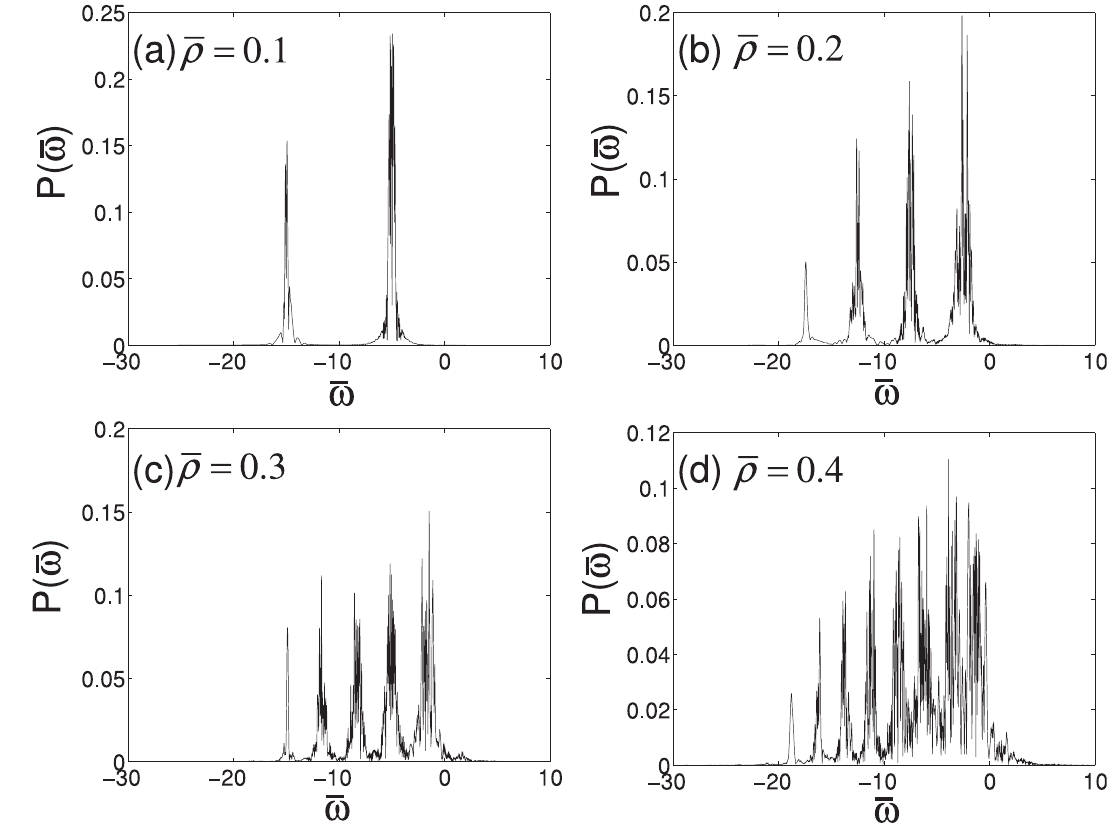
FIG. 4. The transition from quantum SASE to classical SASE: Scaled power spectra, P (cid:5) (cid:1) ! (cid:7) , as a function of scaled frequency (cid:1) ! (cid:1) ! 0 (cid:6) ! for (cid:1) z (cid:1) 150 , calculated from a numerical solution of Eqs. (41) and (42) for (cid:5) (cid:1) 0 when (a) (cid:1) (cid:1) (cid:1) 0 : 1 , (b) (cid:1) (cid:1) (cid:1) 0 : 2 , (c) (cid:1) (cid:1) (cid:1) 0 : 3 , and 2 (cid:1)! (d) (cid:1) (cid:1) (cid:1) 0 : 4